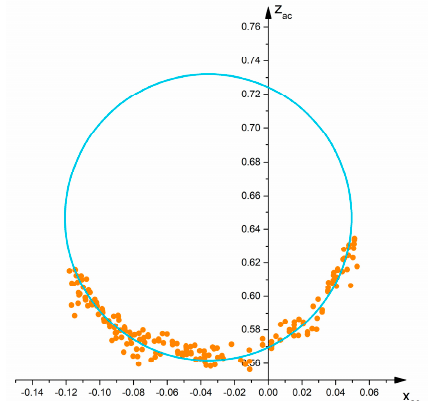
Figure 13. The fitted stem circle at breast height.